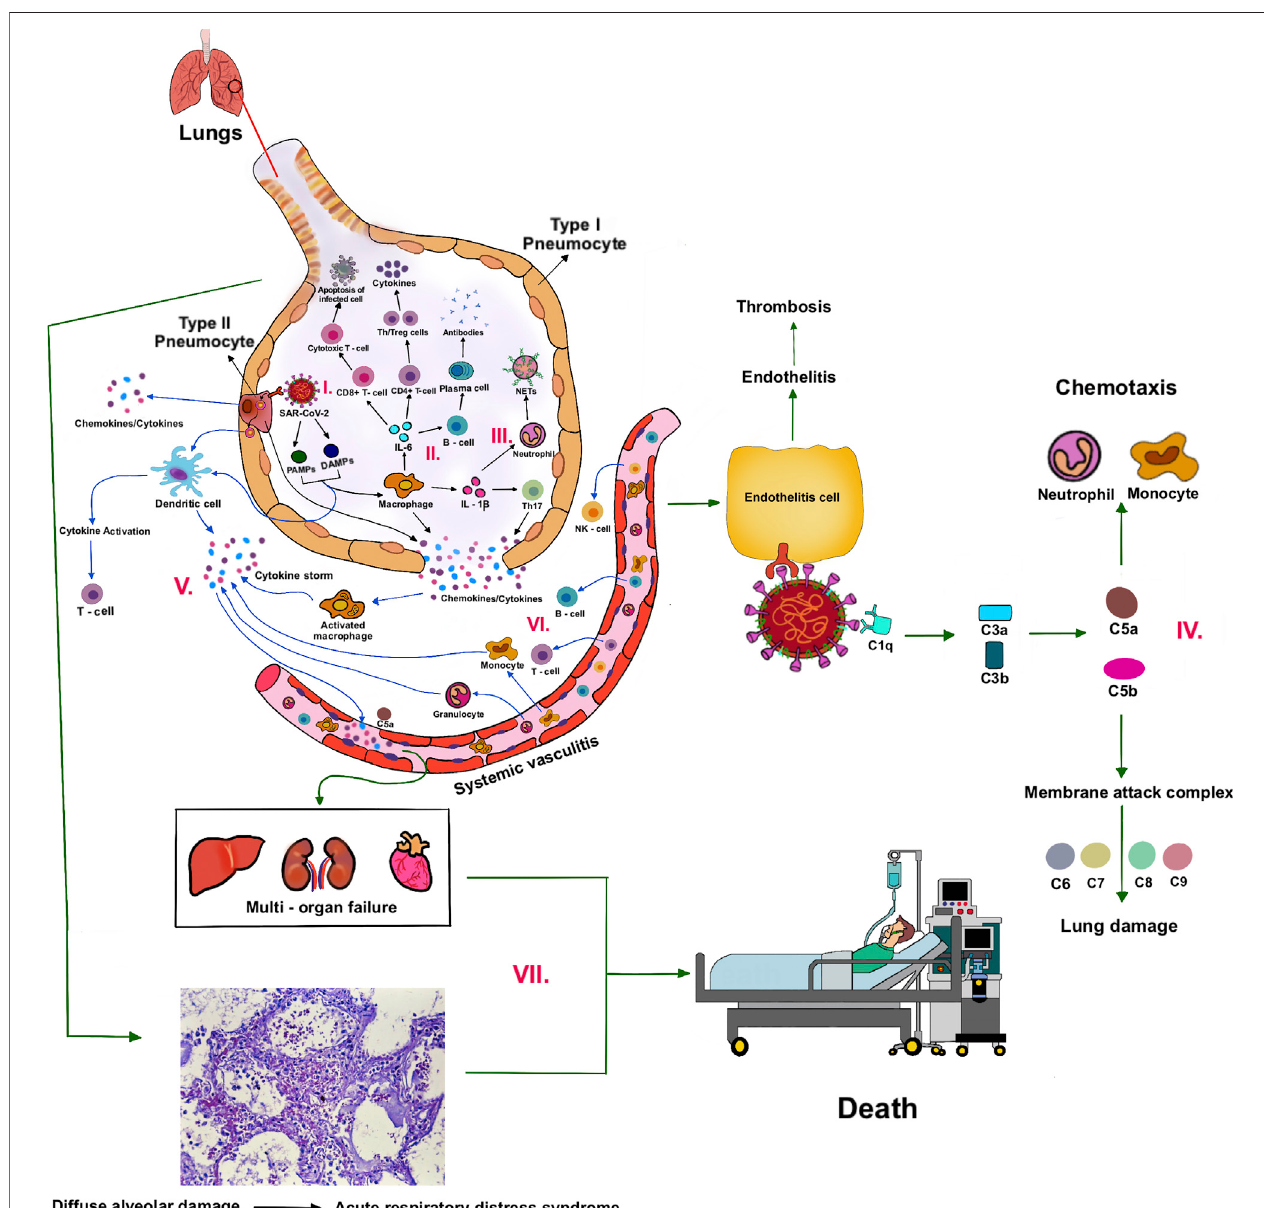
FIGURE 2 | Cytokine storm and pathogenesis of